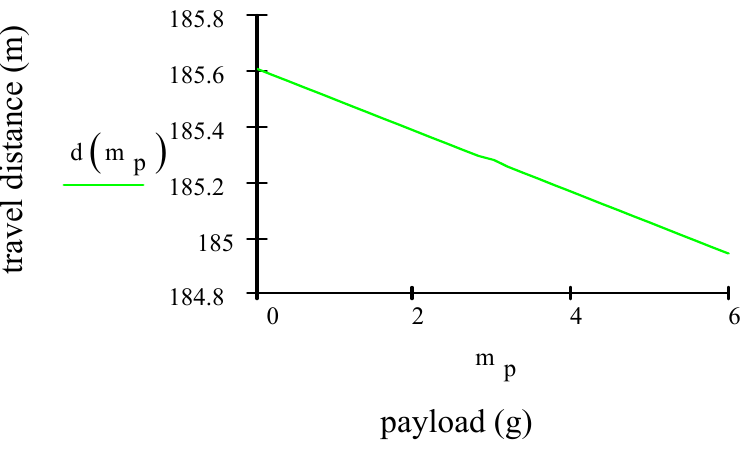
Figure 5. Travel distance vs. payload.